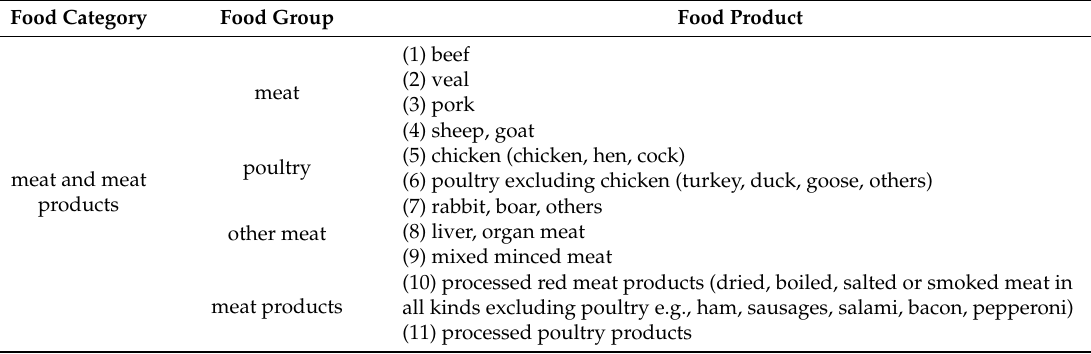
Table 1. Food grouping for the analysis of energy and nutrient sources.